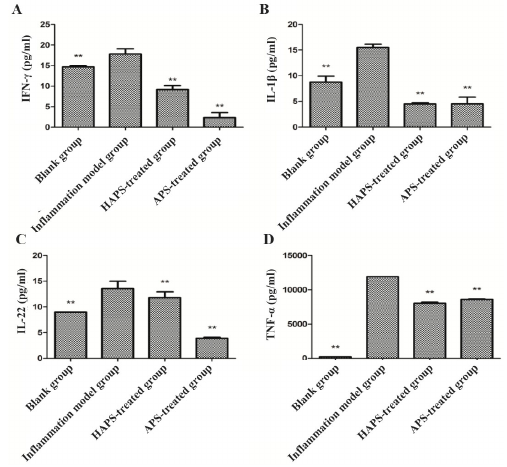
Figure 7. Effects of HAPS and APS on the expression of inflammatory cytokines IFN- γ ( A ); IL-1 β ( B ); IL-22 ( C ) and TNF- α ( D ) in LPS-stimulated RAW264.7 cells. * Indicates the statistical significance of the difference between inflammation model group and blank group, honey-processed-treated group, APS-treated group and Ibuprofen-treated group ( n = 6, ** p < 0.01 vs. inflammation model group).